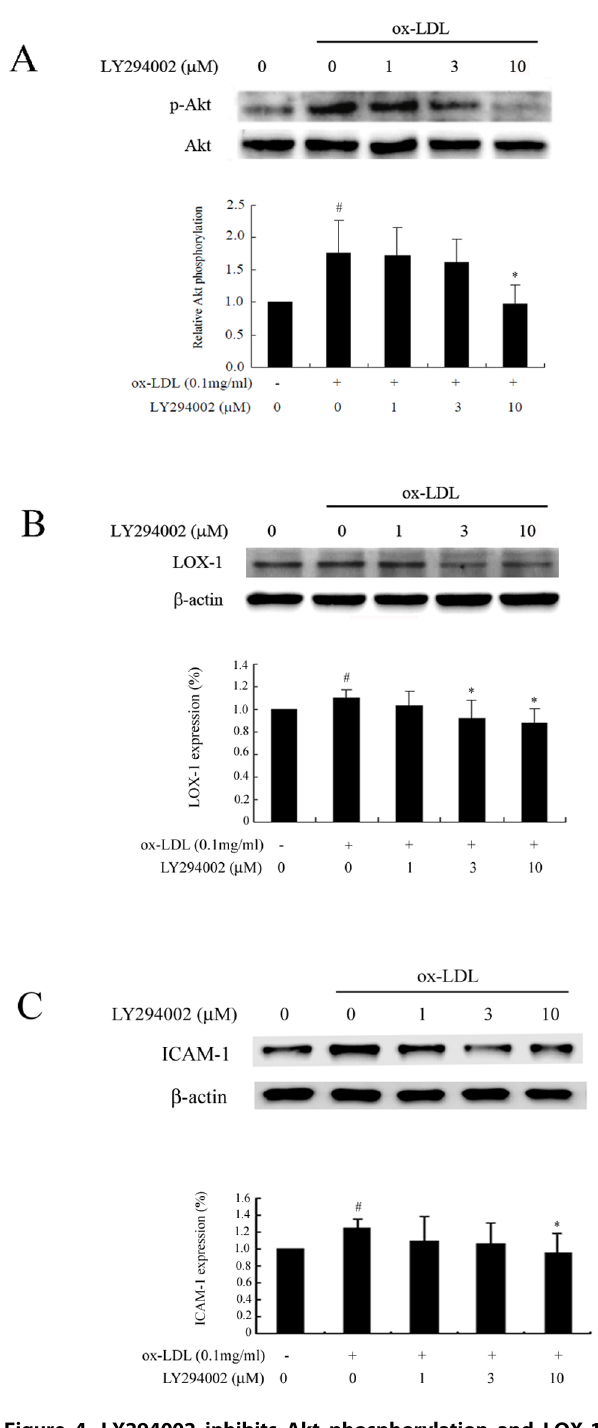
Figure 4. LY294002 inhibits Akt phosphorylation and LOX-1 and ICAM-1 expression in ox-LDL-stimulated endothelial cells. (A) LY294002 suppressed Akt phosphorylation. (B) LY294002 diminished LOX-1 expression. (C) LY294002 reduced ICAM-1 expression. The data were obtained from five independent experiments. # p , 0.05, compared with control; * p , 0.05, compared with ox-LDL-stimulated